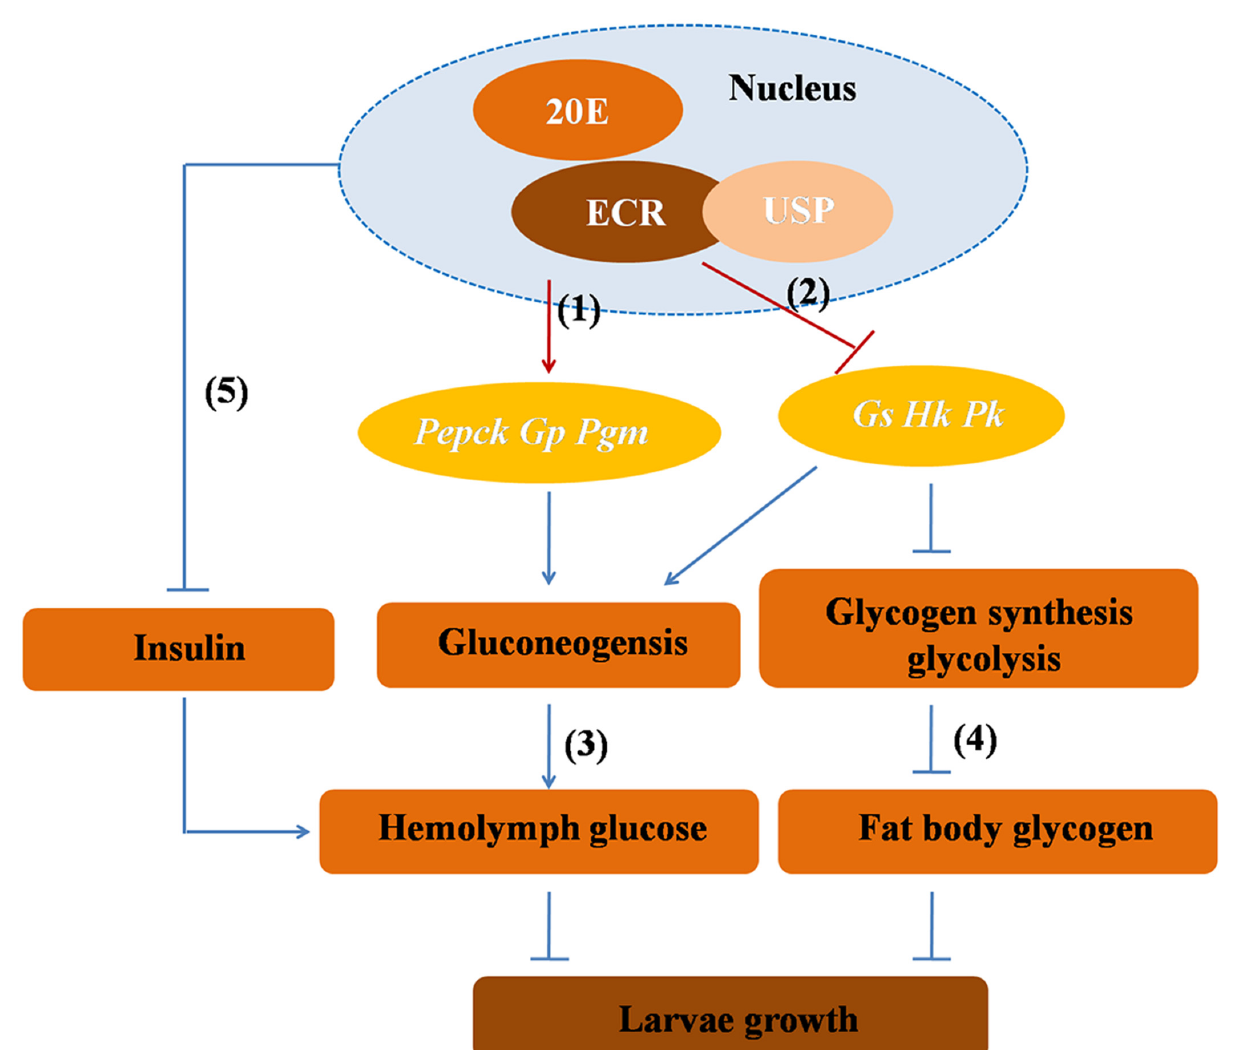
Figure 10. A diagram illustrating 20E regulates glycometabolism reprogramming via nuclear recep- tors (EcR and USP). 20E promotes the expression of Pepck , Gp and Pgm via nuclear receptors (1). 20E suppresses the expression of Gs , Hk and Pk via nuclear receptors (2). The increase in glucose after 20E treatment is due to glycogen degradation, glycolysis inhibition and gluconeogenesis (3). Glycogen levels in the fat body decreased after 20E treatment (4). 20E antagonizes IIS to elevate hemo- lymph glucose levels (5).